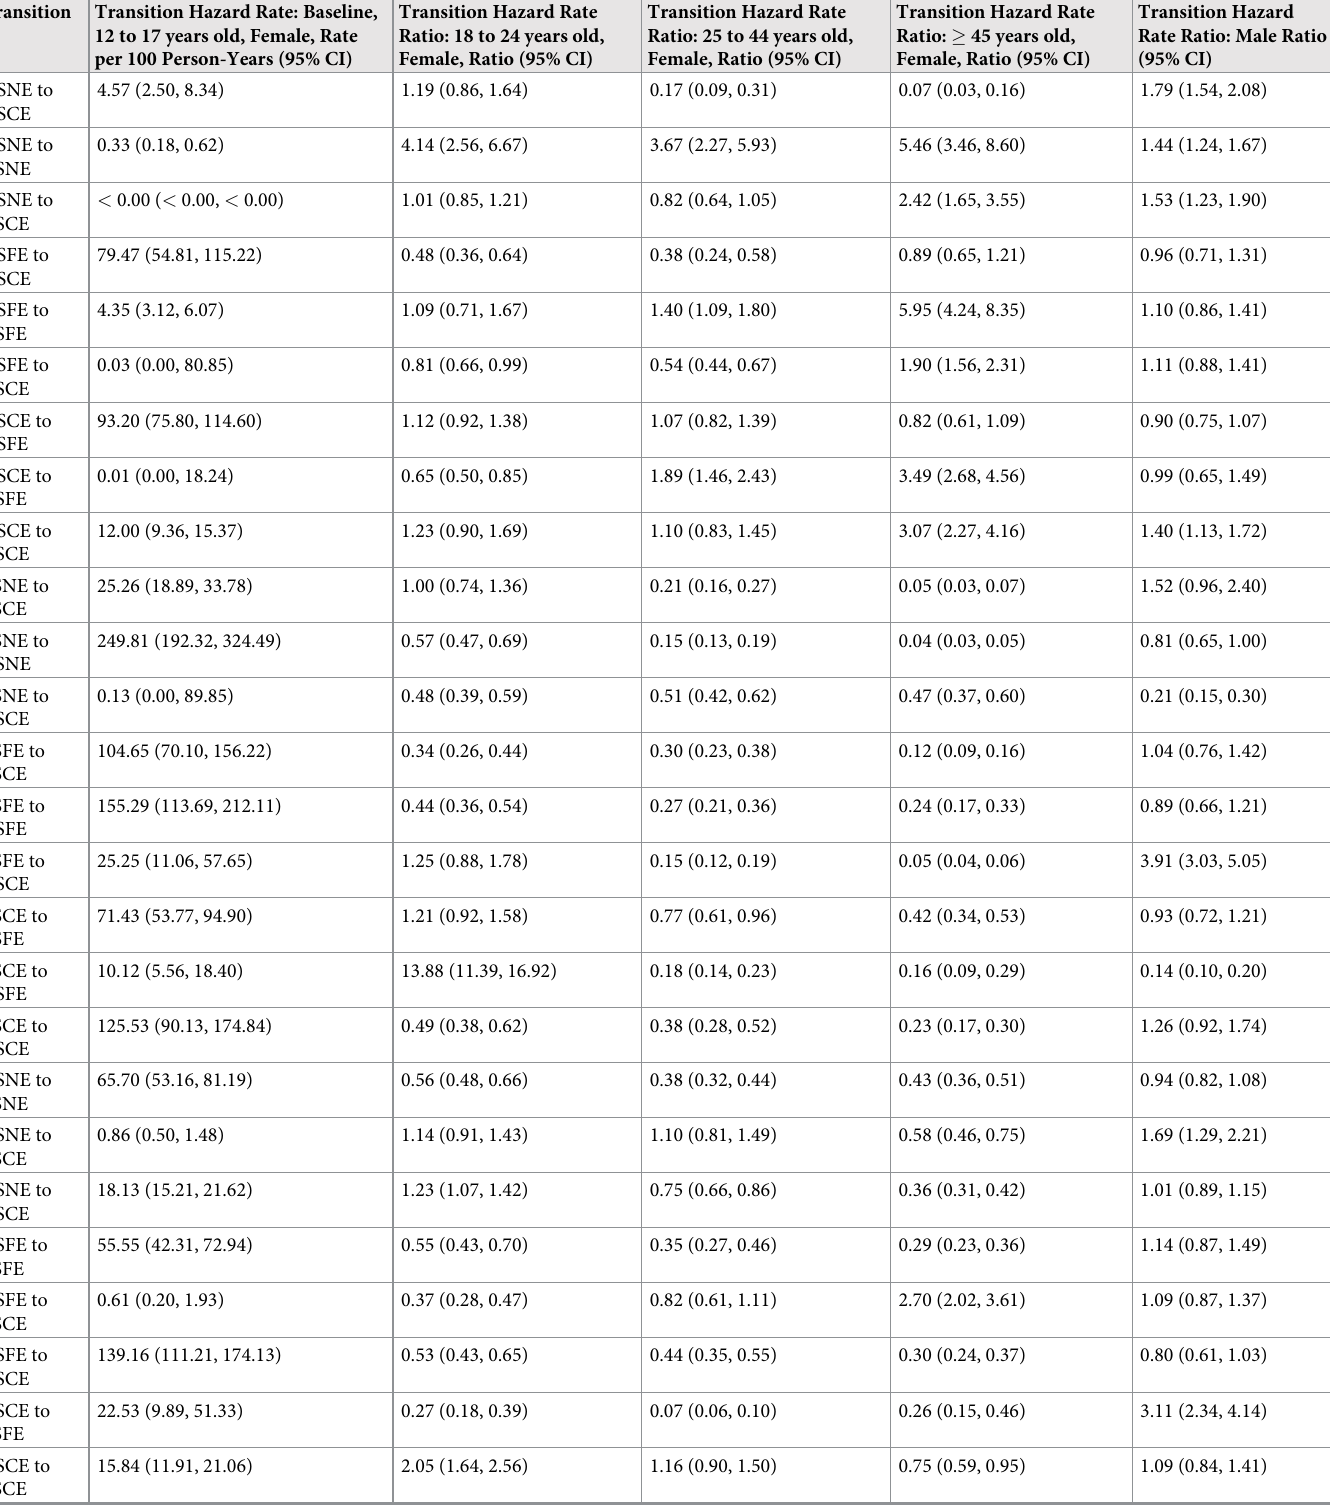
Table 1. Continuous time Markov model-estimated baseline transition hazard rates and adjusted hazard rate